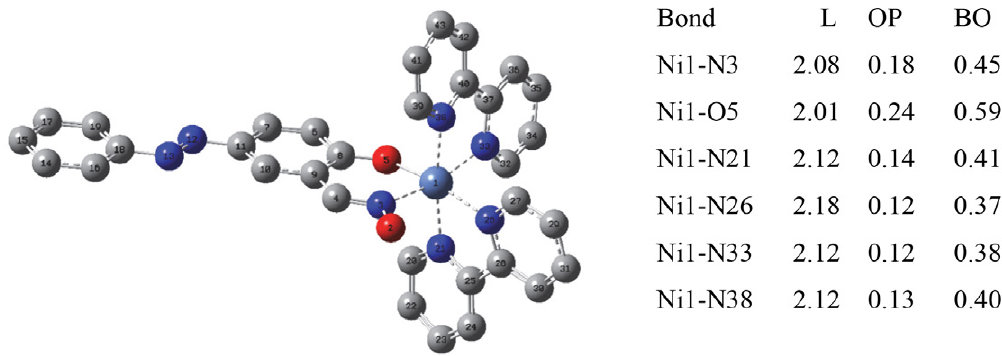
Figure 4: Optimized molecular structure of complex 2 and selected bond length in Å (L), overlap population (OP) and bond order (BO).